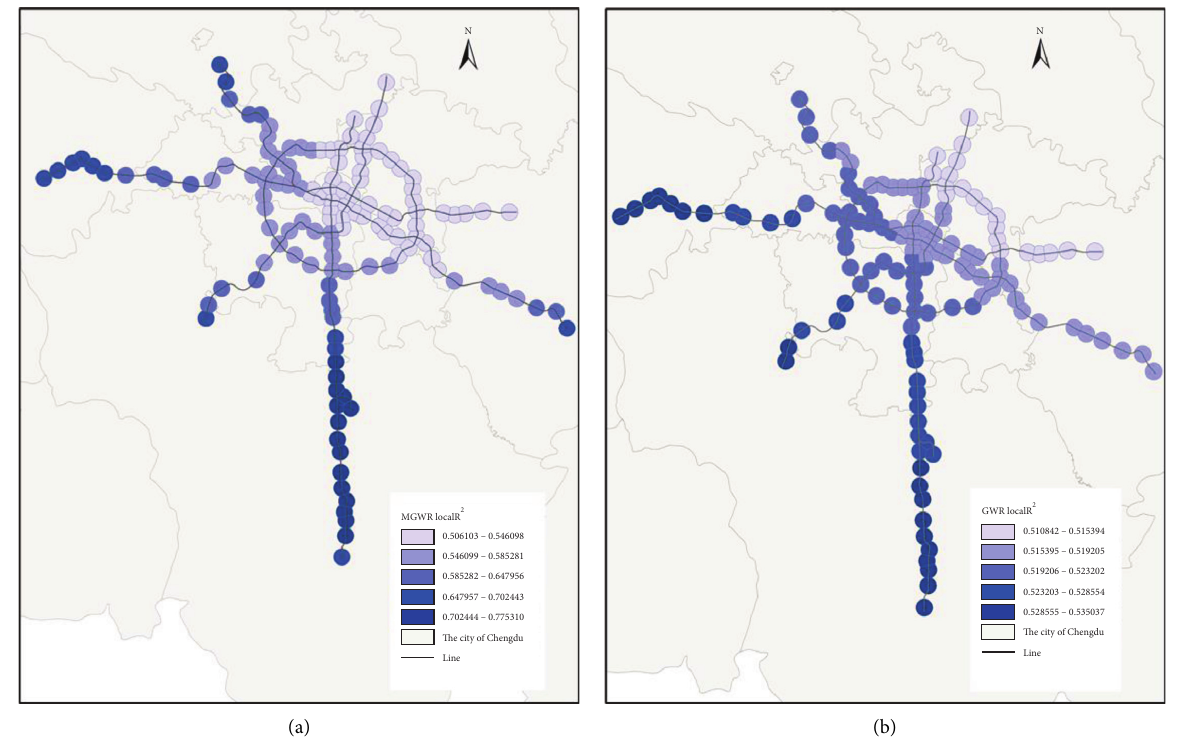
Figure 12: (a, b) Distribution of MGWR model local R 2 and GWR model local R 2